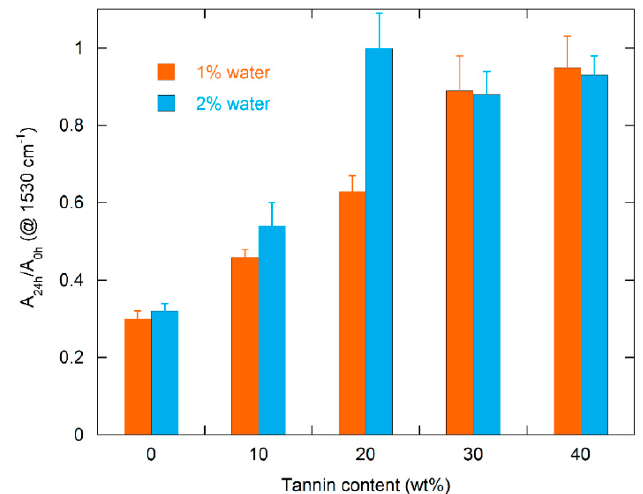
Figure 9. Ratio of areas under the 1530 cm − 1 peak in FTIR spectra (A 24h /A 0h ) measured before (A 0 ) and after (A 24 ) UV irradiation for 24 h.